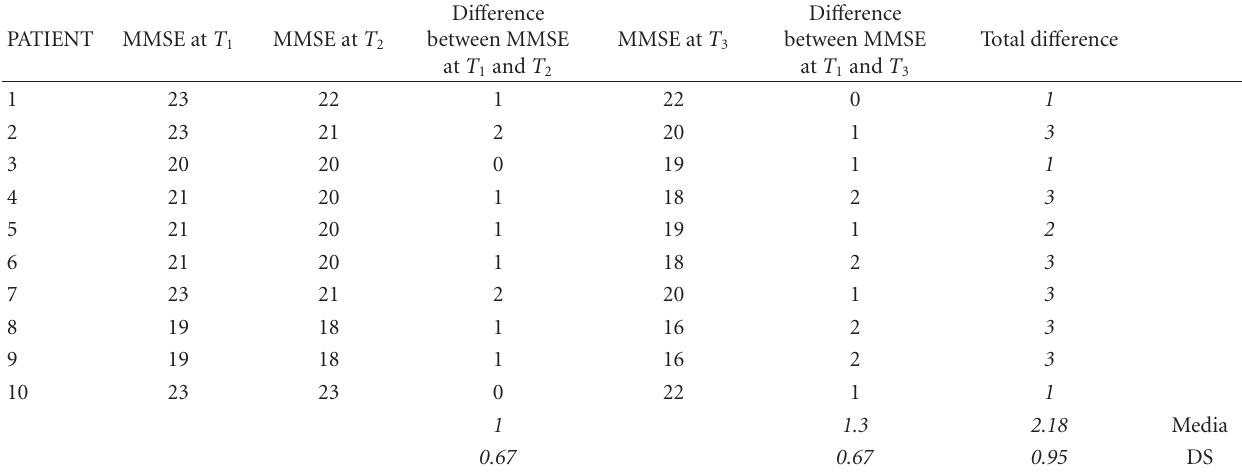
Figure 1: ADM: Abductor Digiti Minimi Muscle, ECD: Extensor Digitorum Communis Muscle. This graph shows that the map centre of gravity of the two muscles considered separately is in controls widely distributed around to hot-spot, while in patients it is evidently located anteromedial to it (modified from [5]). Table 1: Mini mental state evaluation trend over two years in patients examined. T 1 : basal evaluation, T 2 : 1 year after AchE-ib treatment, T 3 : 1 year after the last TMS session, DS: standard deviation. Patients, both as a group and as individual cases, could be considered cognitively stabilized at T 2 and at T 3 and formed an homogeneous group (modified from